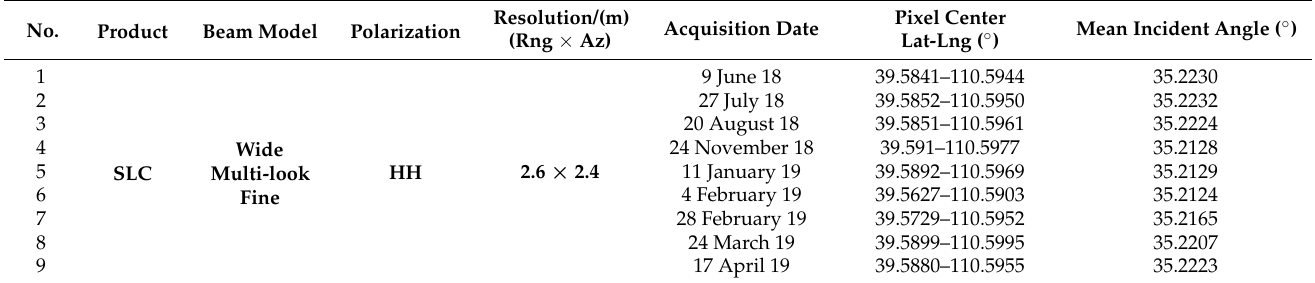
Table 2. Parameters of RadarSat-2 images over WangJiata mine